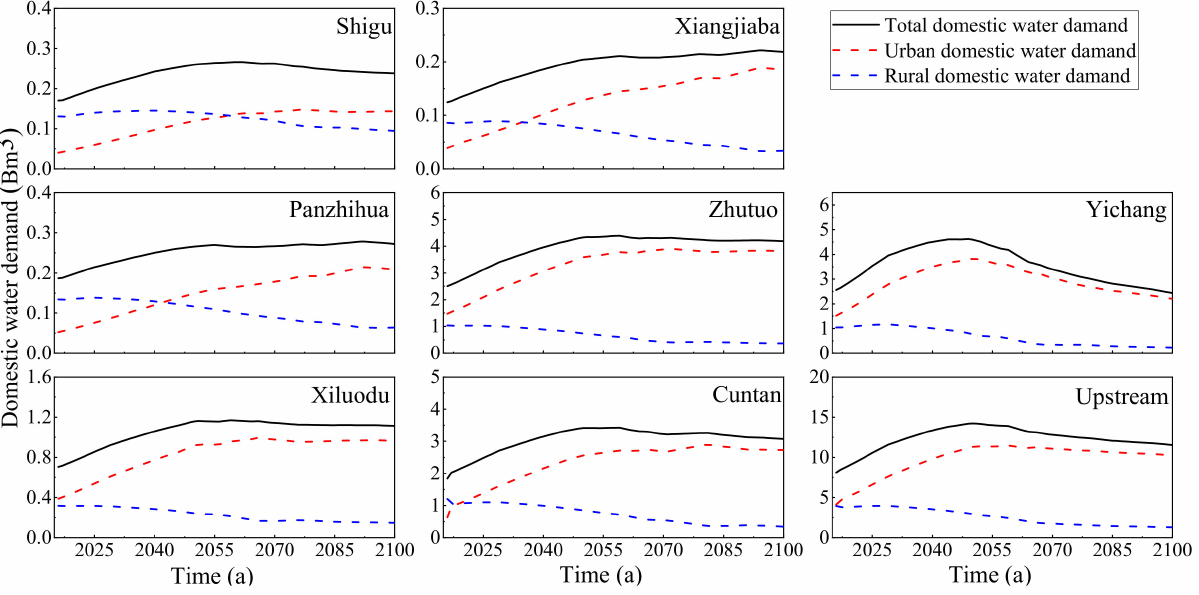
Figure 15. Domestic water demand forecasting in each